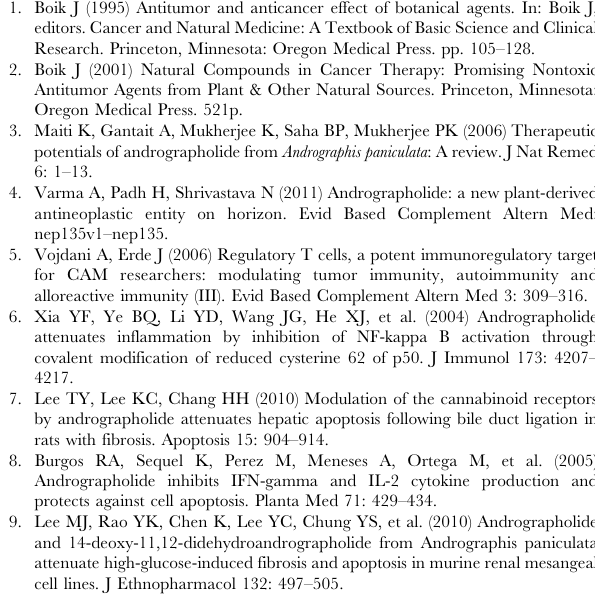
Figure S4 Double-strand siRNA depletion of MAD2 protein in DU145 cells. DU145 cells were transfected with three different siRNA against MAD2 gene or control siRNA for 24 h and the protein extracts from these cells were separated and analyzed with an anti-MAD2 specific antibody (upper panel) and actin antibody (lower panel). The actin control was used for normalization of loading of protein in each